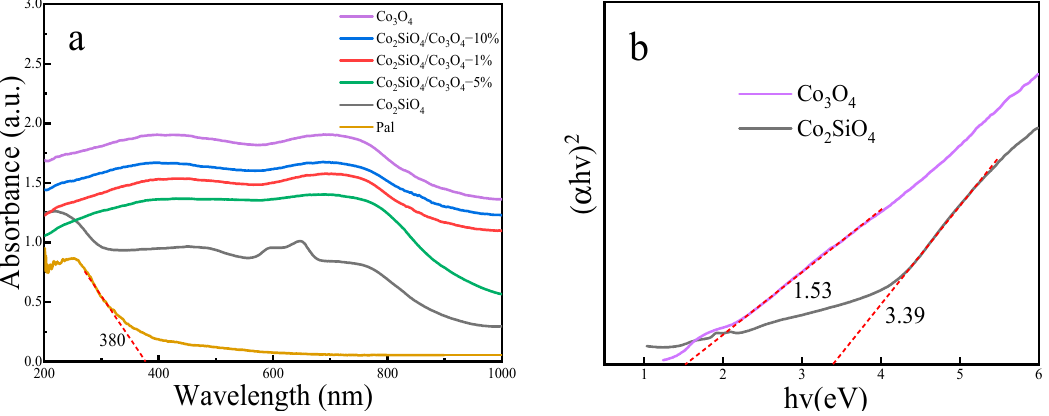
Figure 3. ( a ) UV-Vis-NIR absorption spectra of Pal, Co 3 O 4 , Co 2 SiO 4 , and Co 2 SiO 4 /Co 3 O 4 − x. ( b ) Tauc curves of Co 2 SiO 4 and Co 3 O 4 .